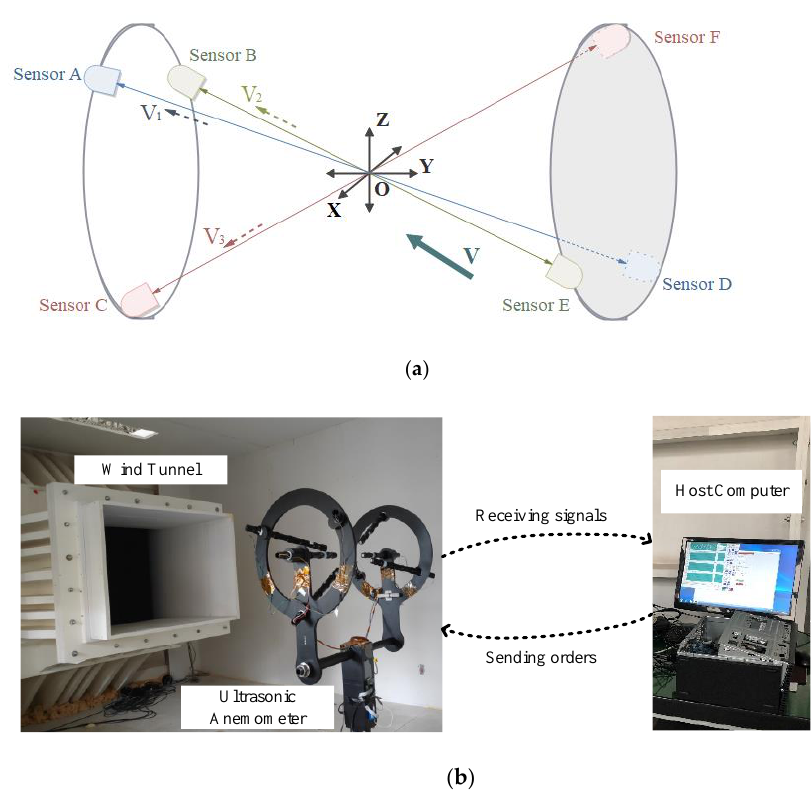
Figure 5. Experimental device: ( a ) Structure of experimental anemometer; ( b ) anemometer in wind tunnel.